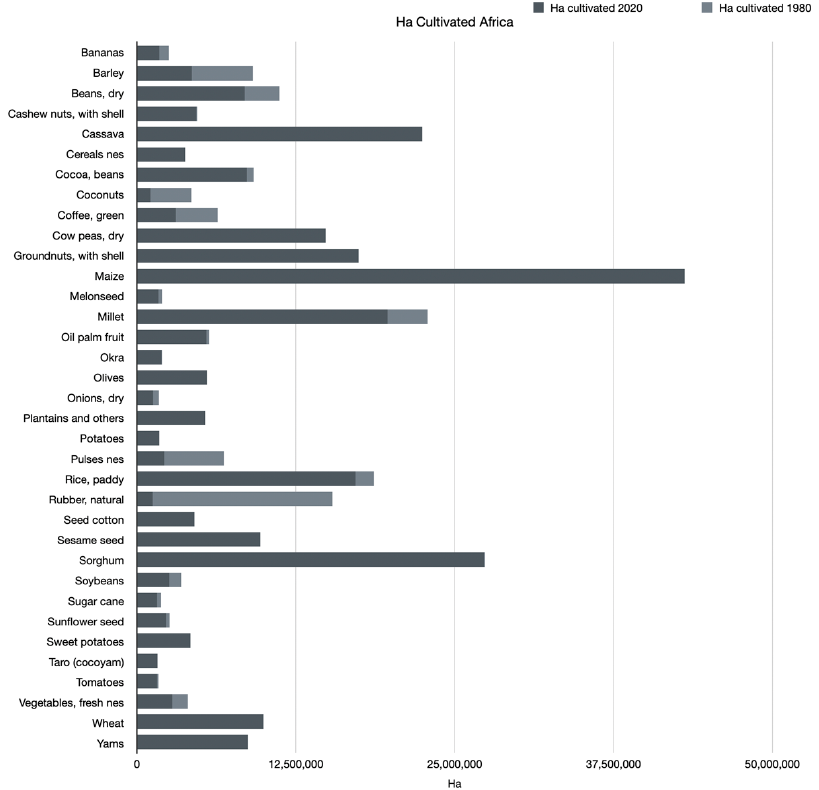
Figure 1. Crops production with an extension higher than 100,000 Ha in Africa, adapted from [25].